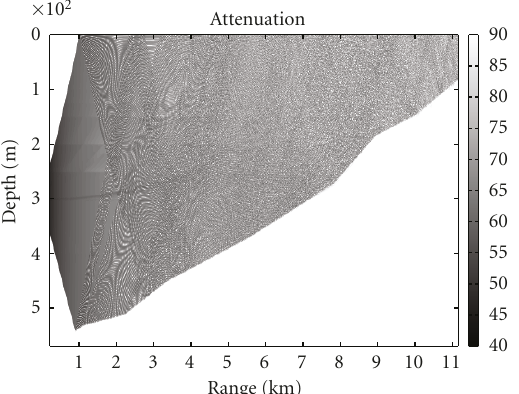
Figure 10: Attenuation incurred by acoustic waves at 4kHz transmitted in March approximately 20 km o ff shore Taranto harbor, 40 . 32 ◦ N, 17 . 12 ◦ E. A darker shade of grey represents a stronger signal. The figure refers to the same geographical area of Figure